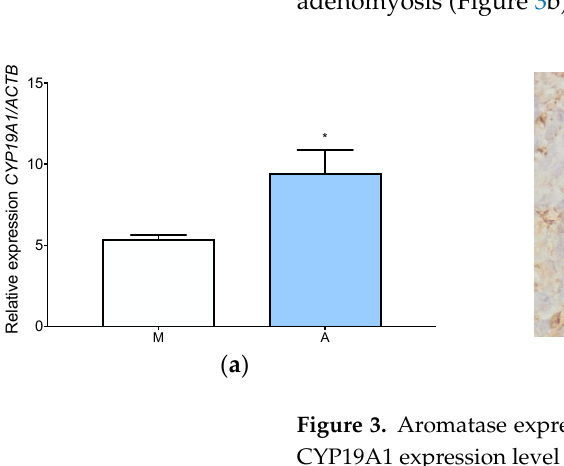
of adenomyosis (Figure 3b). Weak staining was also observed in the stromal cells